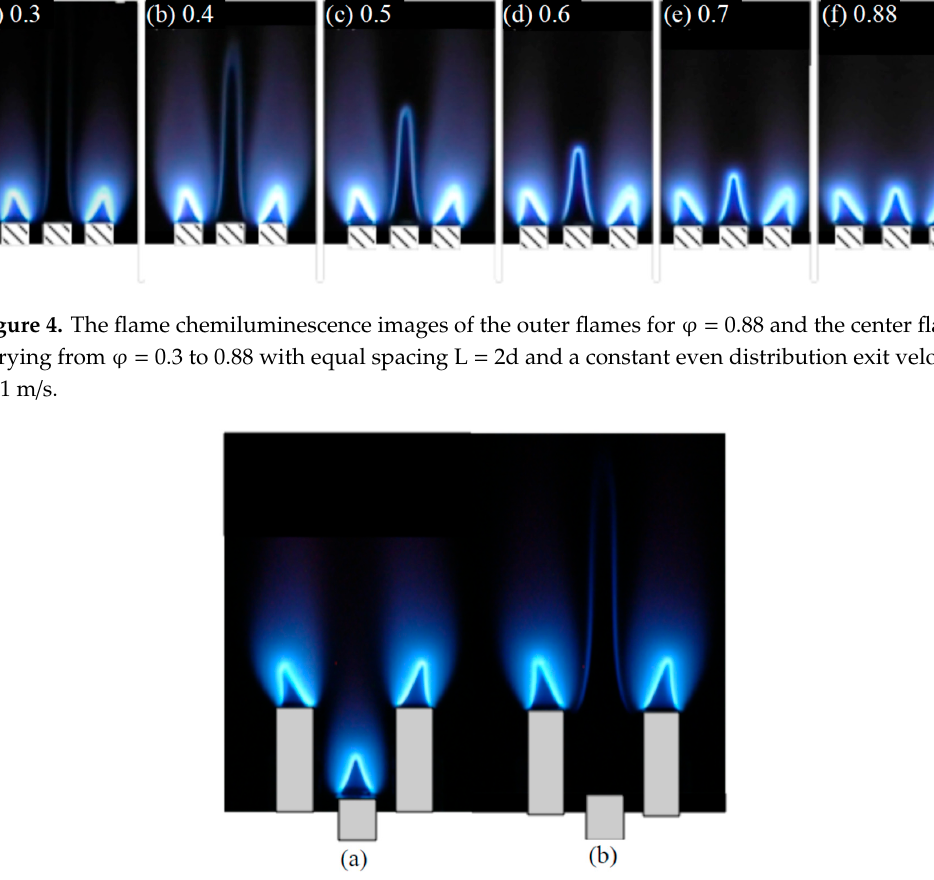
Figure 5. The flame chemiluminescence images of the triple-jet burner for the cases with the center flame equivalence ratio ( a ) ϕ = 0.88 and ( b ) ϕ = 0.4, when the center jet was intentionally placed in an upstream location.